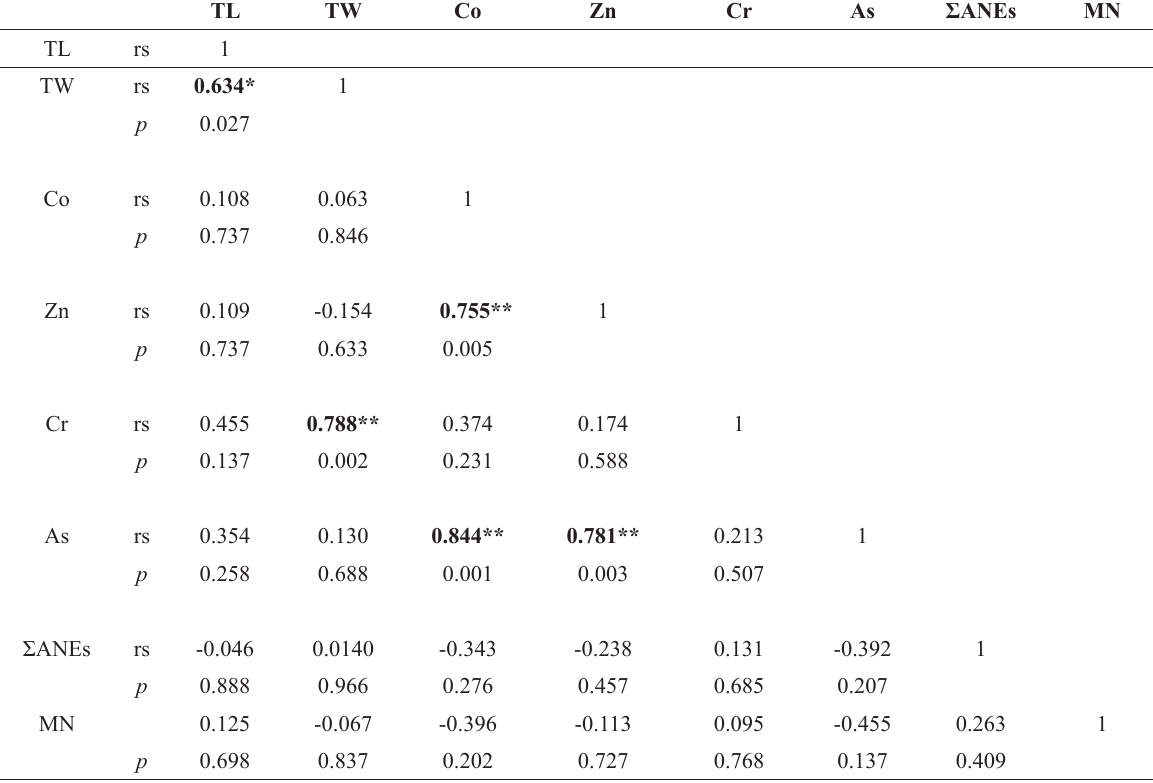
Correlation Spearman coefficient (rs) of biological parameters (total length – TL - and total weight - TW), cobalt (Co), zinc (Zn), chromium (Cr), arsenic (As), and genotoxic biomarkers (NAE and MN) in fish species from the inner area and Santos Bay in Santos/São Vicente estuary (SSV). Analyzed samples =